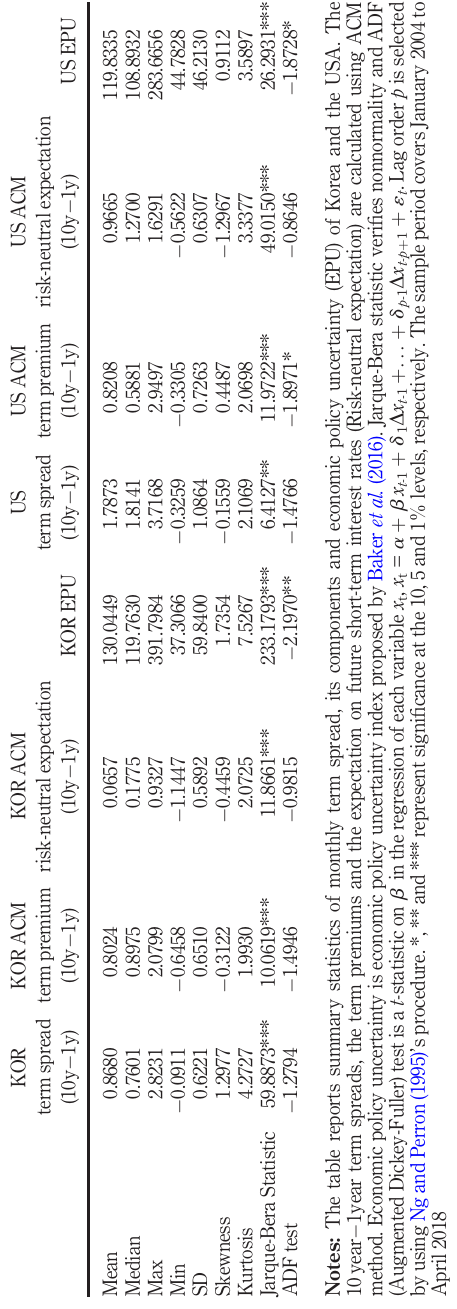
Table 2. Summary